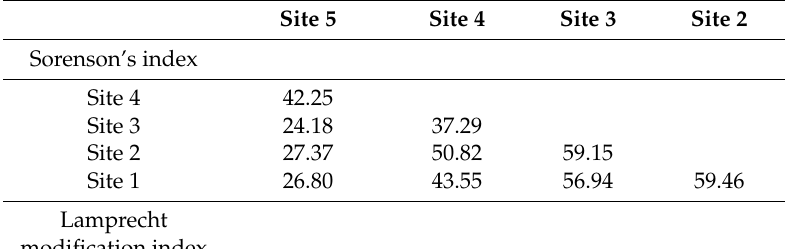
Table 4. Similarity indices of forests between the five study sites.